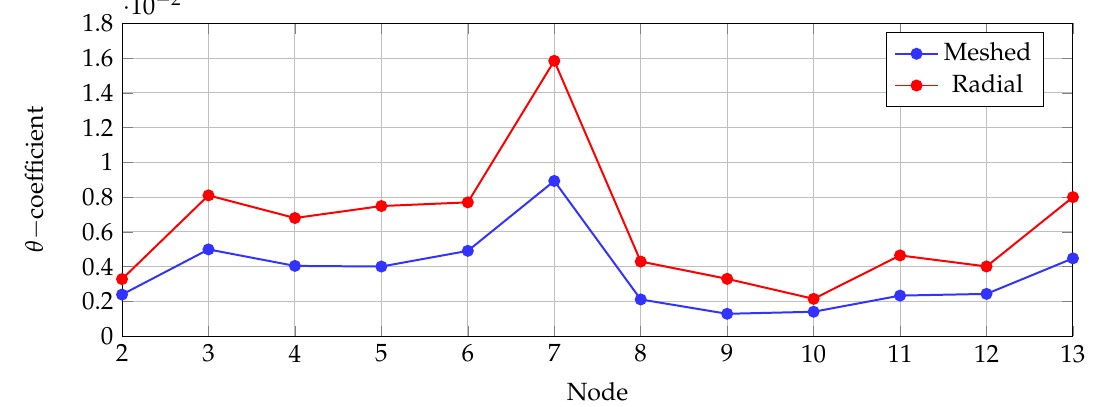
Figure 4. Behavior of the θ − coefficient in the 13-node test feeder in the case of radial and mesh configurations.